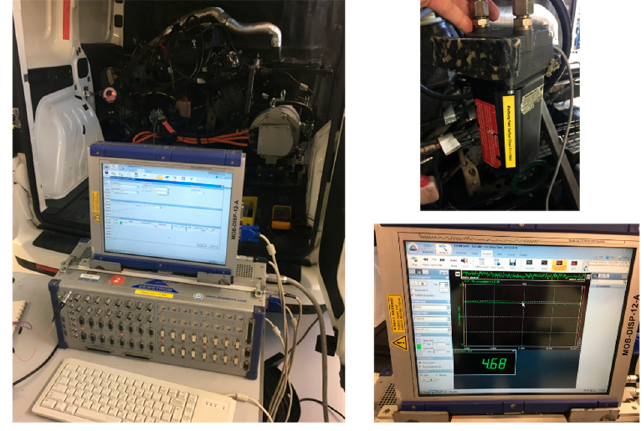
Figure 8. Fuel-consumption test on APU with fuel-consumption test device.